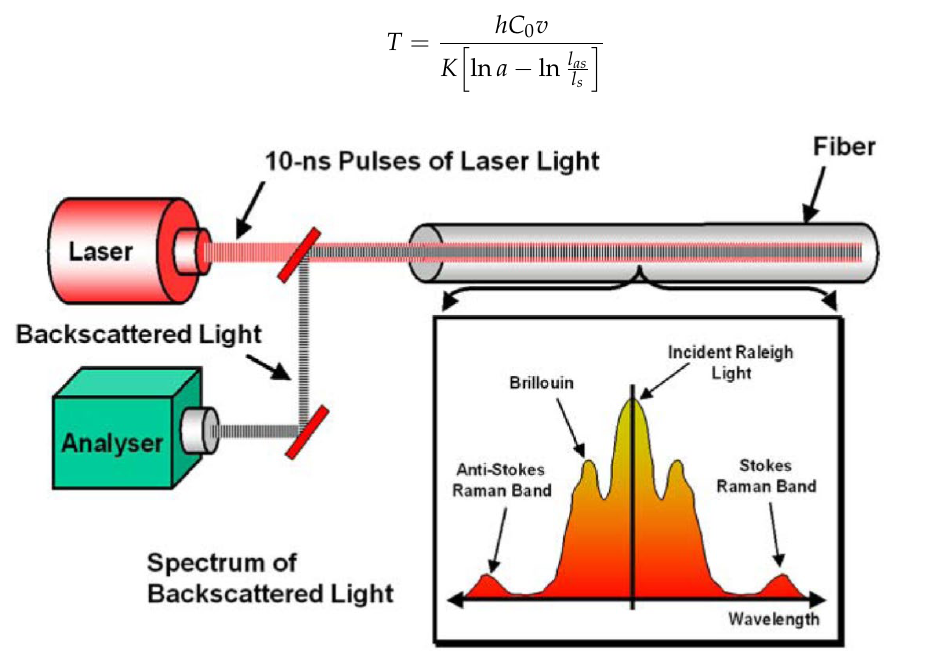
Figure 1. The principle of DTS measurement [11].